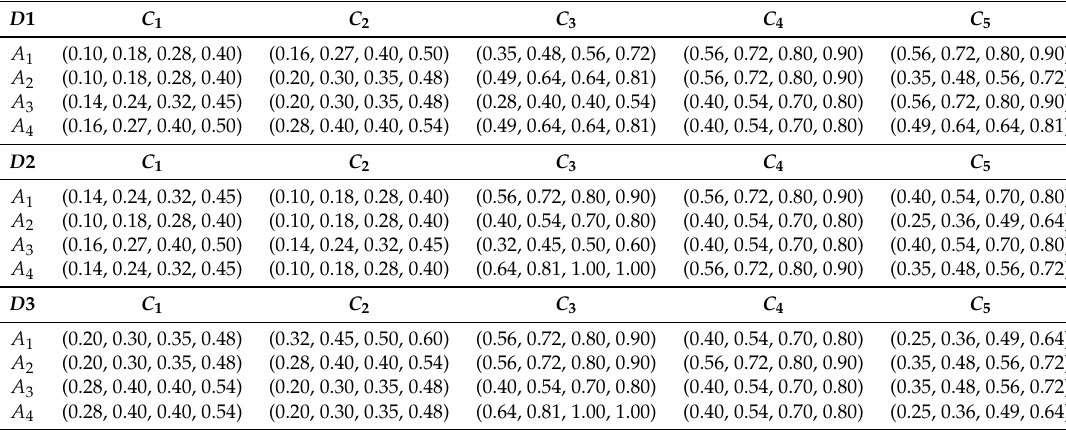
Table 3. The weighted fuzzy coefficient matrix ˜ D k .